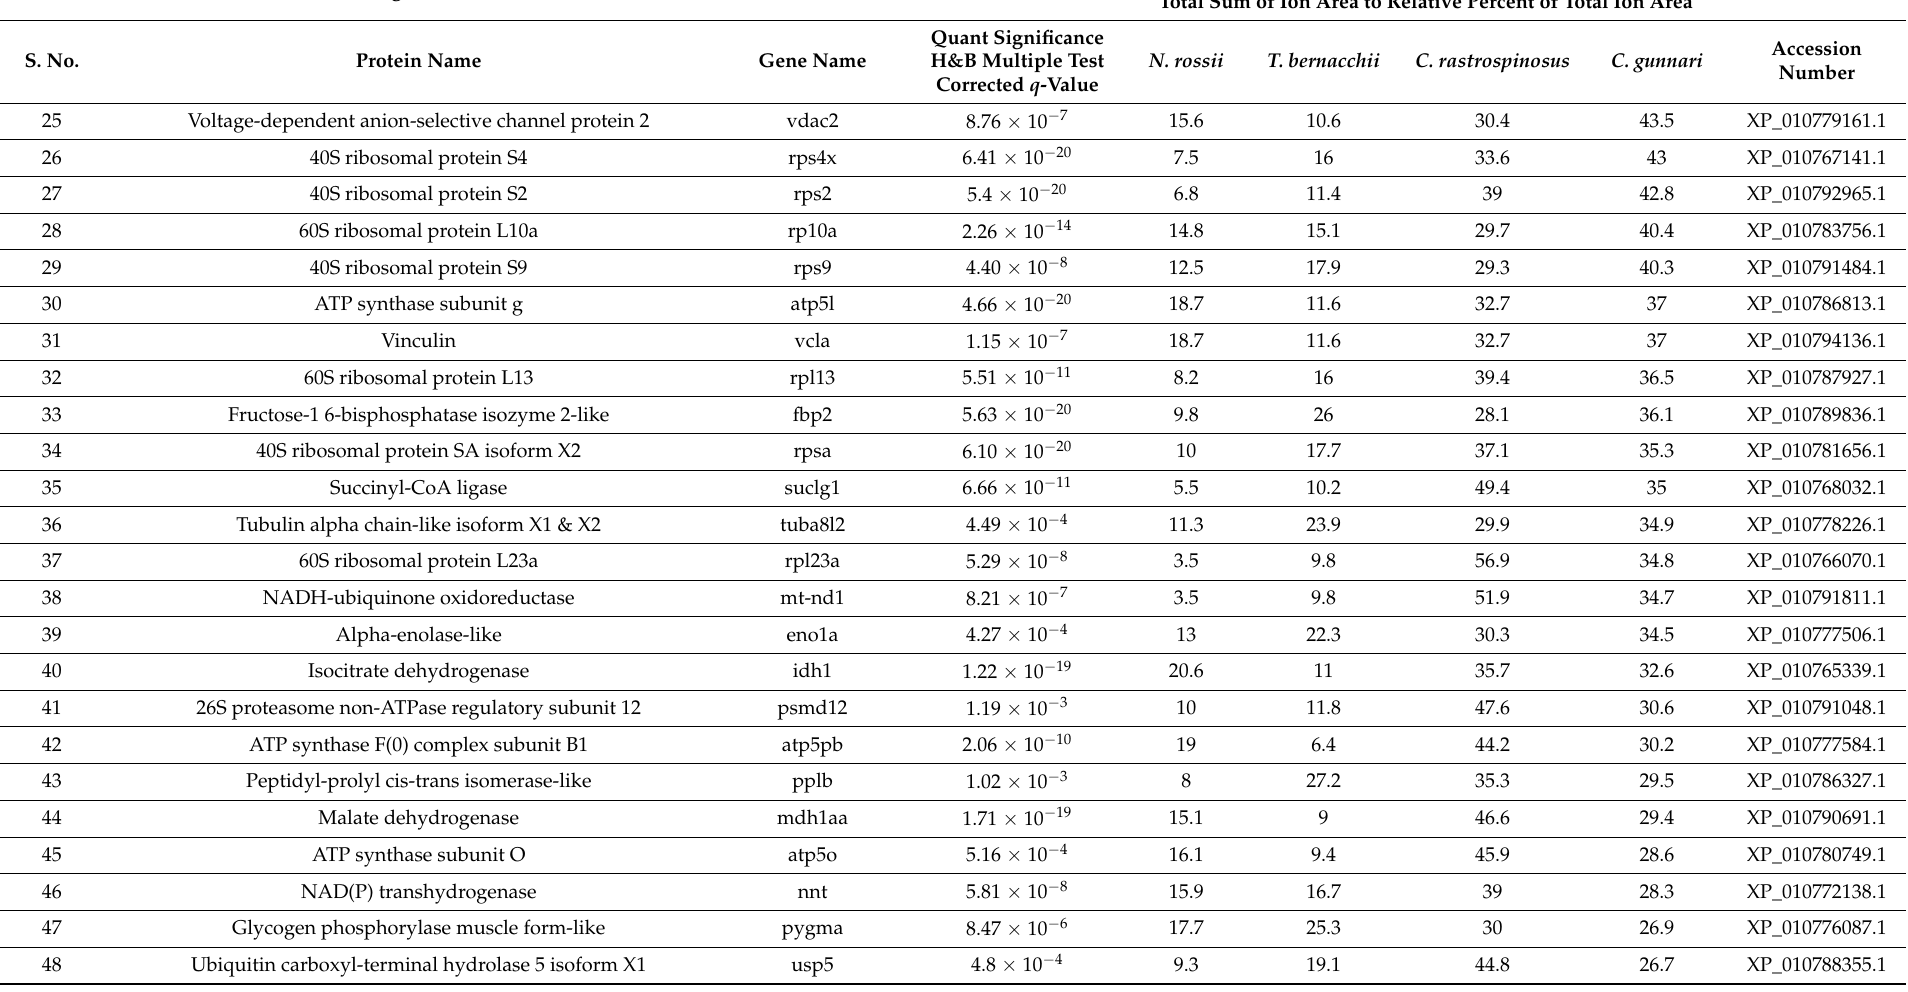
Protein Abundance—Higher in Icefish (White